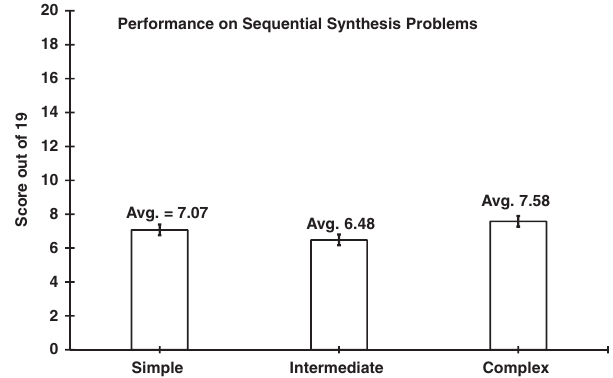
FIG. 5. Overall performance on the three sequential synthesis tasks. Error bars represent standard errors.